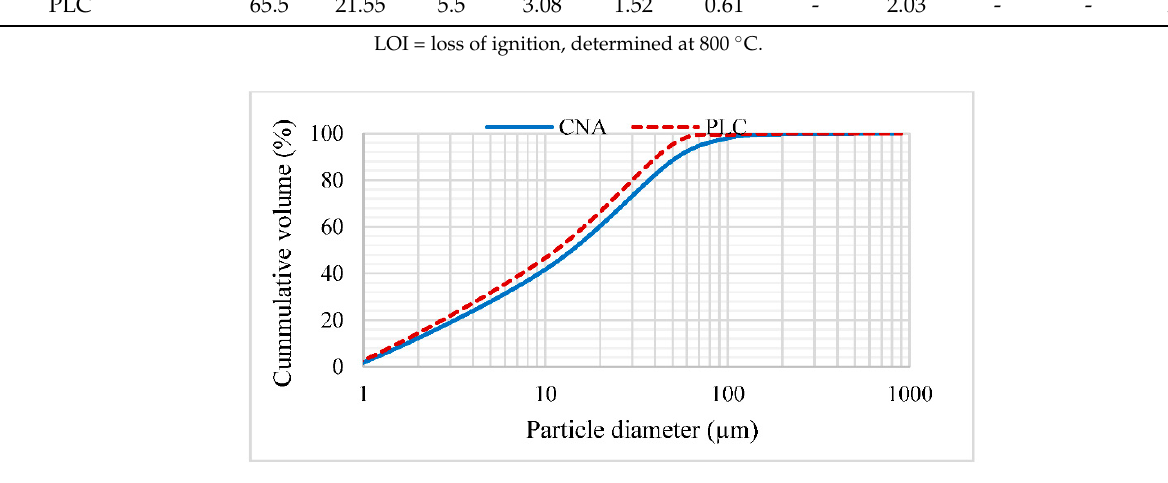
Figure 2. The PSD of aggregates used. CA is coarse aggregate, FA is fine aggregate, and LL and UL are lower and upper limits. 2.2. Design Proportions and Concrete Strength Specifications BS EN 206 [25] was used to design the trial mix proportions, considering the mate- rials’ physical characteristics. Portland limestone cement (PLC) was replaced with CNA at 5, 10, and 15 wt. % proportions because a 15% maximum substitution of PLC with CNA exhibited an optimum compressive strength for structural applications [26,27]. Concrete grades M 25, M 30, and M 40 targeted the respective concrete strengths 25, 30, and 40 MPa at 28 days curing were adopted due to their general uses in the building construction. Ultimately, the trial mix design results are presented in Tables 2–4 for M 25, M 30, and M 40, respectively. Table 2. Mix design proportions for M 25. Mix ID